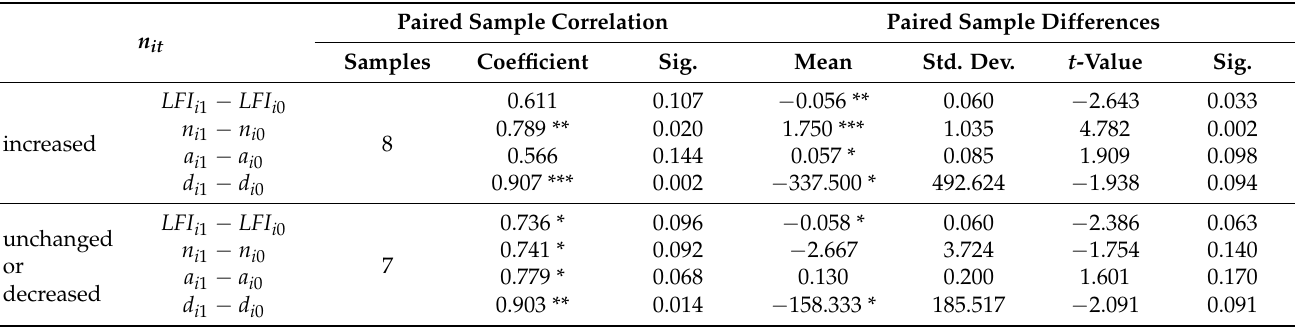
Table 8. Results of paired sample t -test for change of LF degree in scenario 3. Paired Sample Correlation Paired Sample